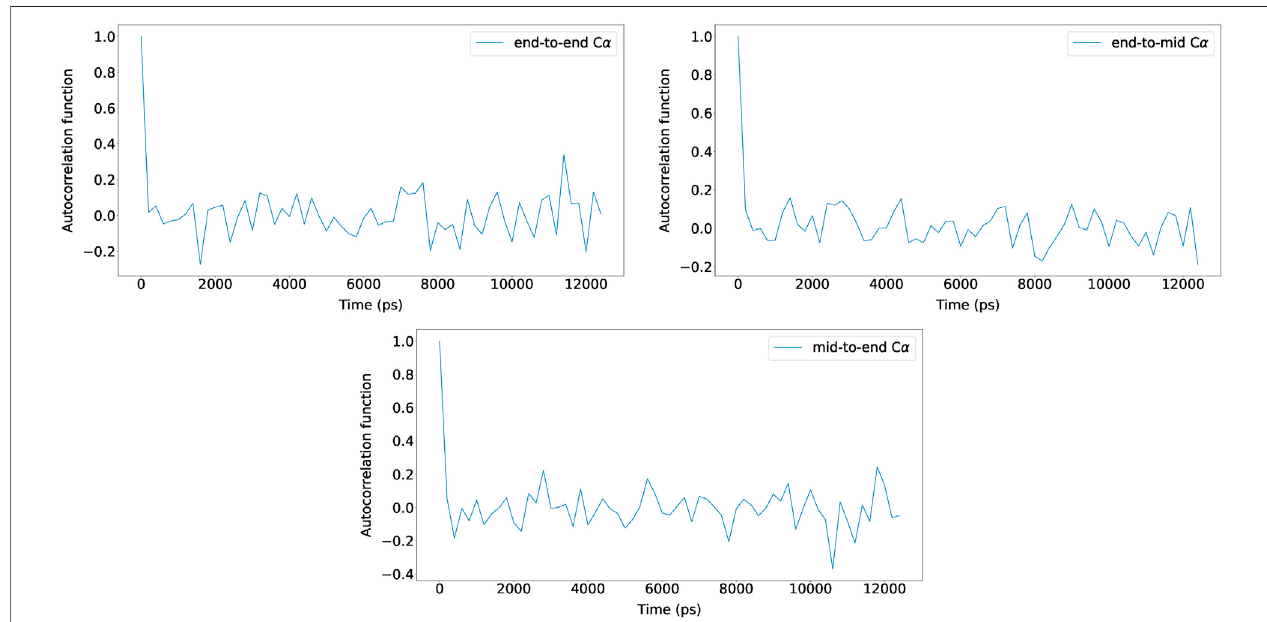
FIGURE 3 | Autocorrelation functions of N-terminusC α to C-terminusC α distance, N-terminusC α to middle C α distance, and middle C α toC-terminus C α distance for (Glu-Lys) 25 sv = 10 at NaCl 15 mM (reference concentration) with scaling factor 0.786. The autocorrelation functions from one of the ten trajectories are shown for clarity and the rest are included in the Supplementary Material